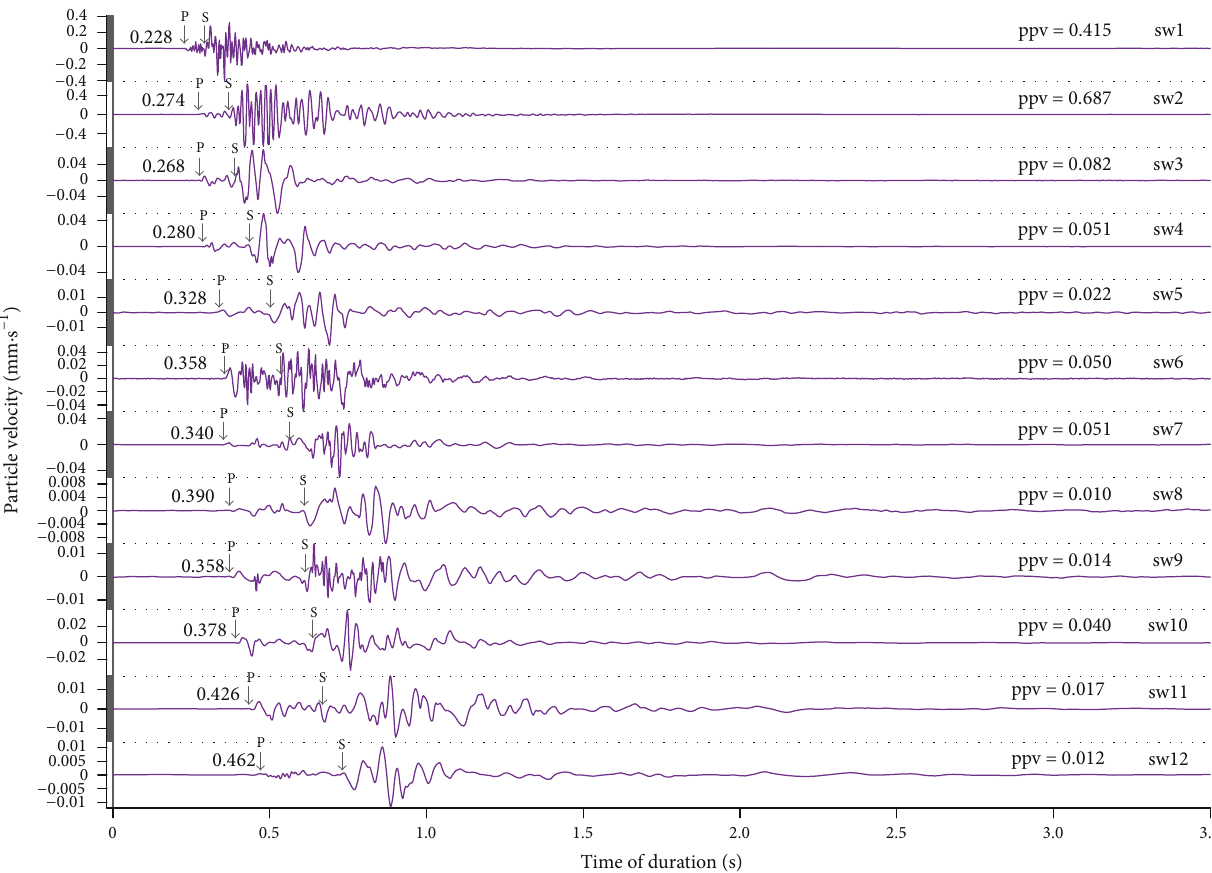
Figure 12: Recognizable waveform of the pure microseismic waves reconstructed via the extracted effective wave component in other monitoring